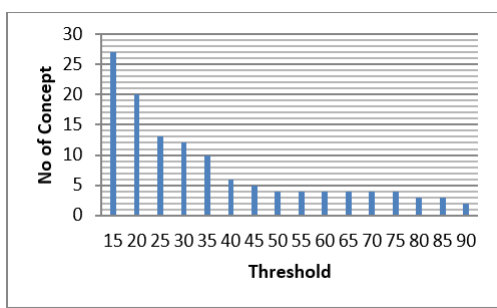
Figure 3. No of Concept extracted Vs Threshold